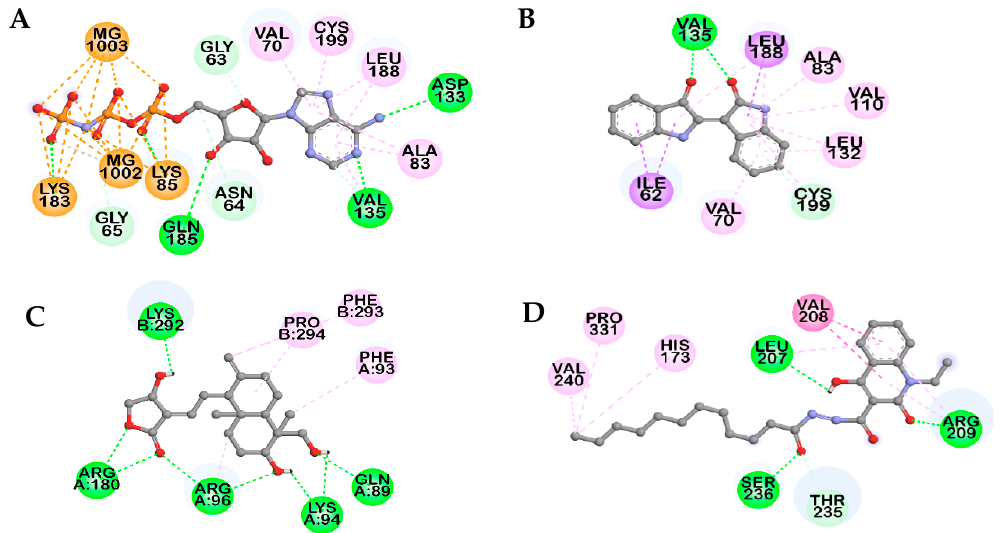
Figure 5. 2D Diagram showing the binding of reference controls, AMP-PNP ( A ), indirubin ( B ), andrographolide ( C ), and VP0.7 ( D ), to GSK-3 β active site.